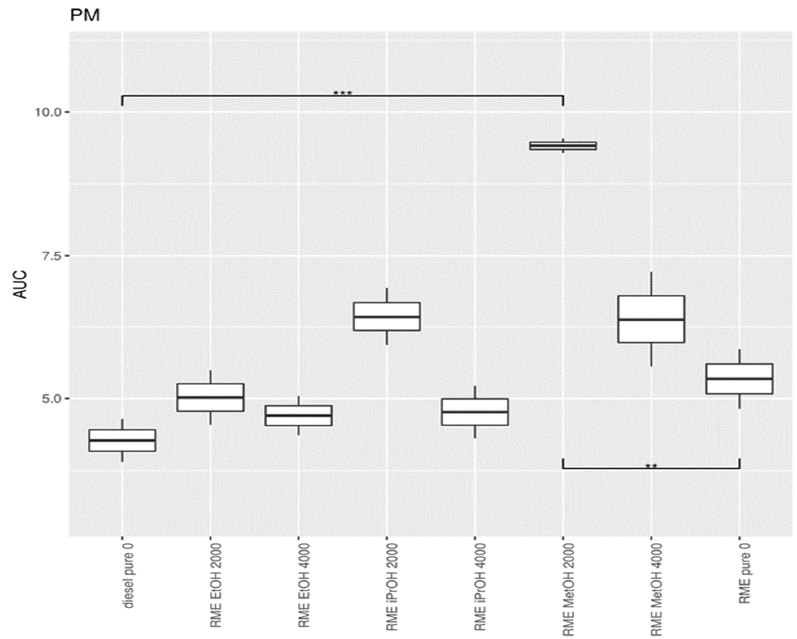
Figure 16. Boxplot of the statistical analysis of the concentration of PM in the exhaust gas. The center lines show the mean AUC value, obtained through bootstrap resampling. Asterisks show the significance of the pairwise comparison of the AUC values ** = p < 0.01; *** = p < 0.001).